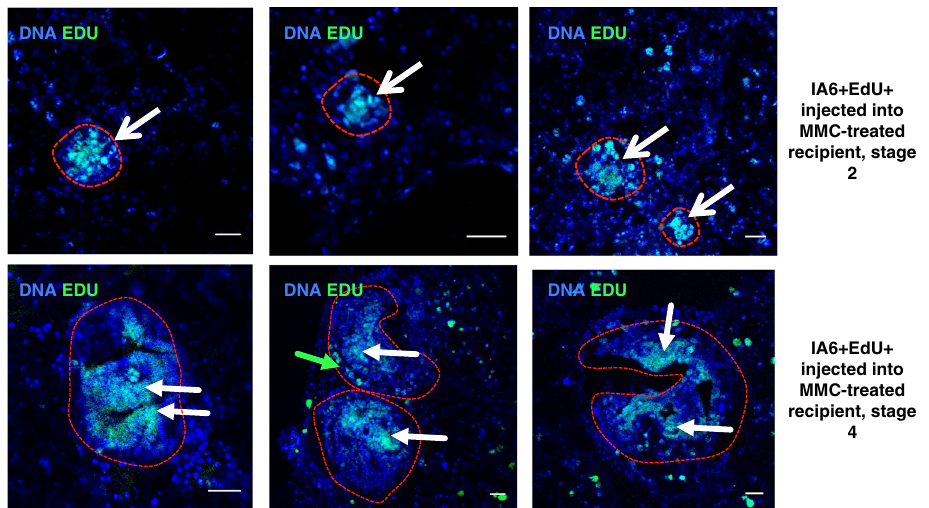
Fig. 4 IA6 + cells give rise to regenerating tissues. Overlay of nuclear staining (Hoechst, blue) and Edu (green). IA6 + cells were isolated from Edu- treated animals and injected into MMC-treated vessel fragments. Edu-positive cells give rise to regeneration foci at late stage 2 or regenerating bodies at stage 4 (white arrows). Scale bars 20 μ m. Images are representative of ten samples from two independent